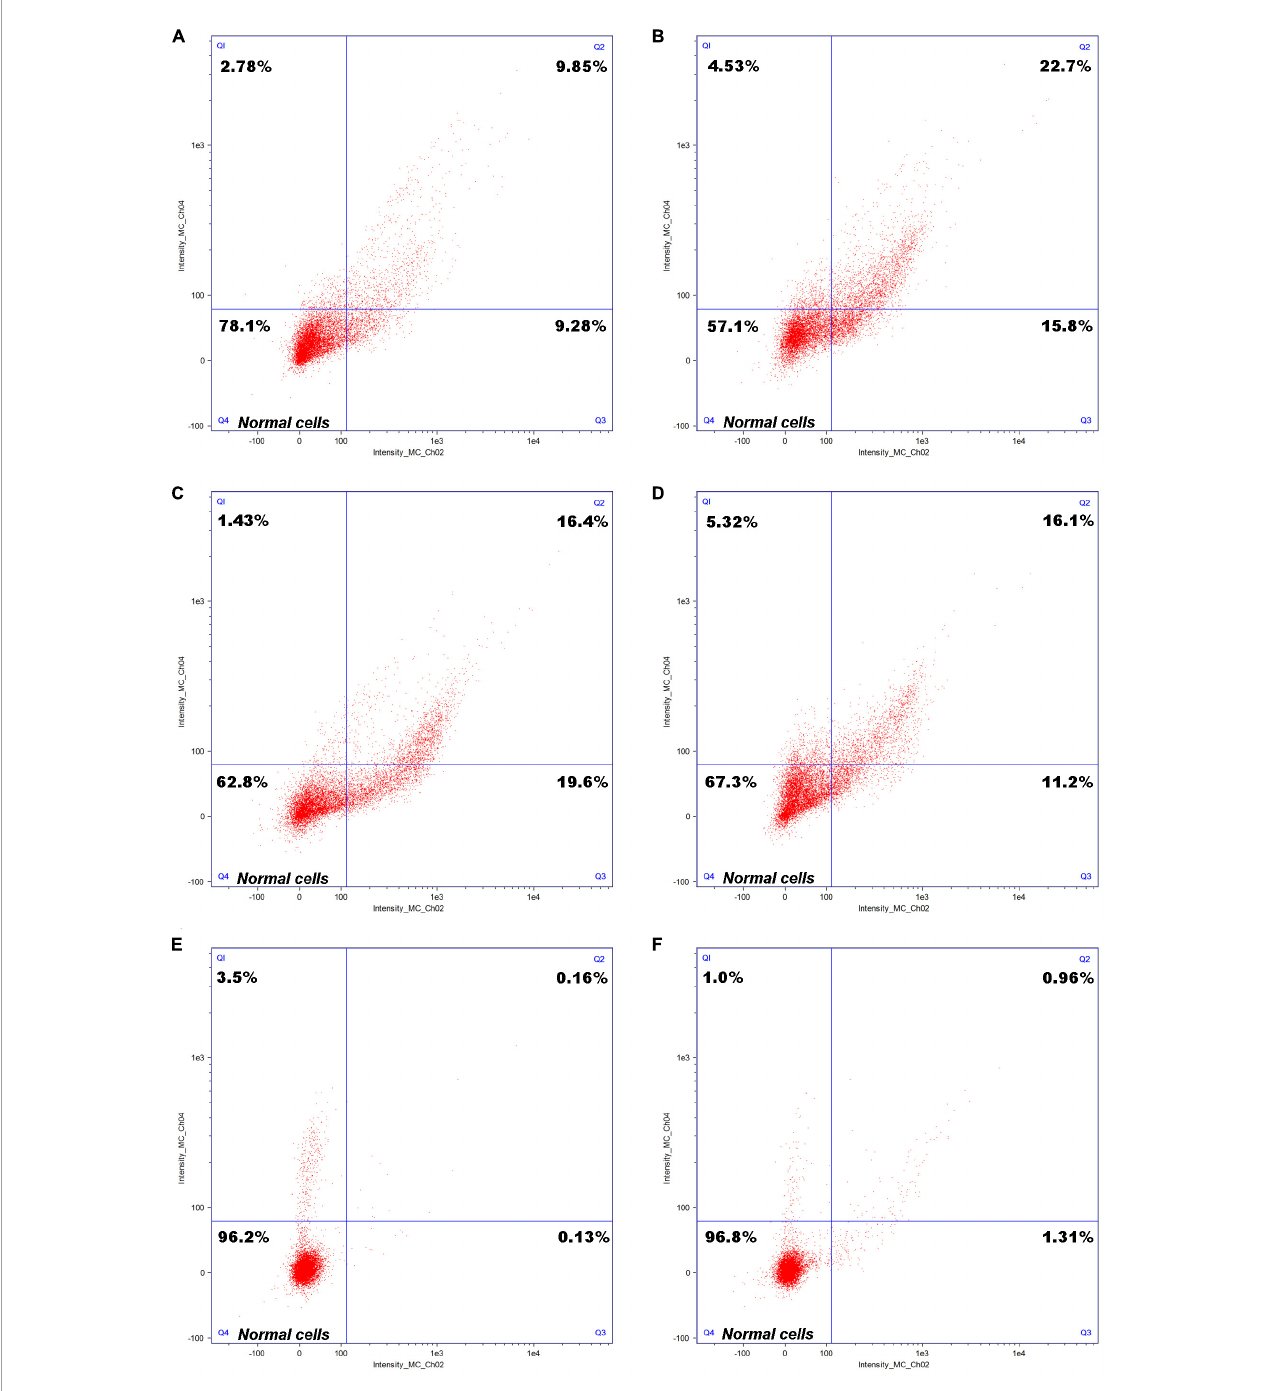
FIGURE3 Cell staining of Clostridium tyrobutyricum with differently treated refinery final molasses samples. Cell staining of C. tyrobutyricum cultured to a logarithmic growth phase grown in refinery final molasses for (A) 6 h and (B) 12 h; after acid-base treatment for (C) 6 h and (D) 12 h; and after final treatment with 0.45 µ m ionic membrane for (E) 6 h and (F) 12